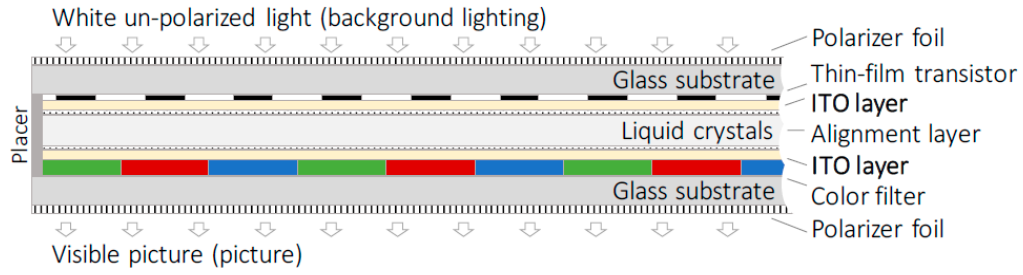
Figure 1. Sandwich construction of a liquid crystal display (LCD) [9].